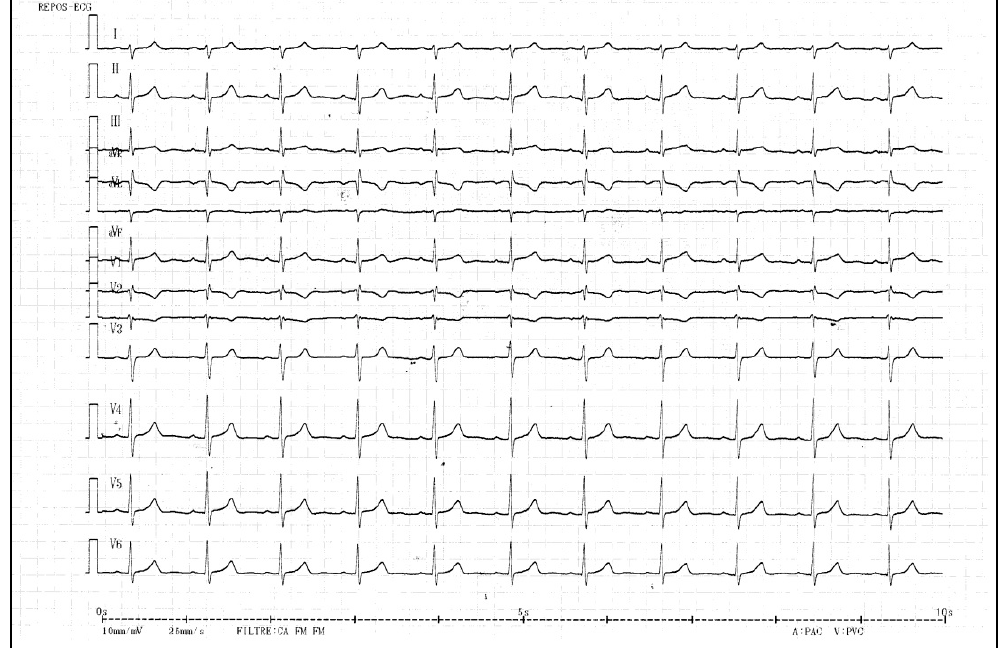
Figure 1. The 12 leads ECG at rest of the index case: a normal T wave inversion is present in the precordial leads V1 and V2 (QTc = 432 ms).